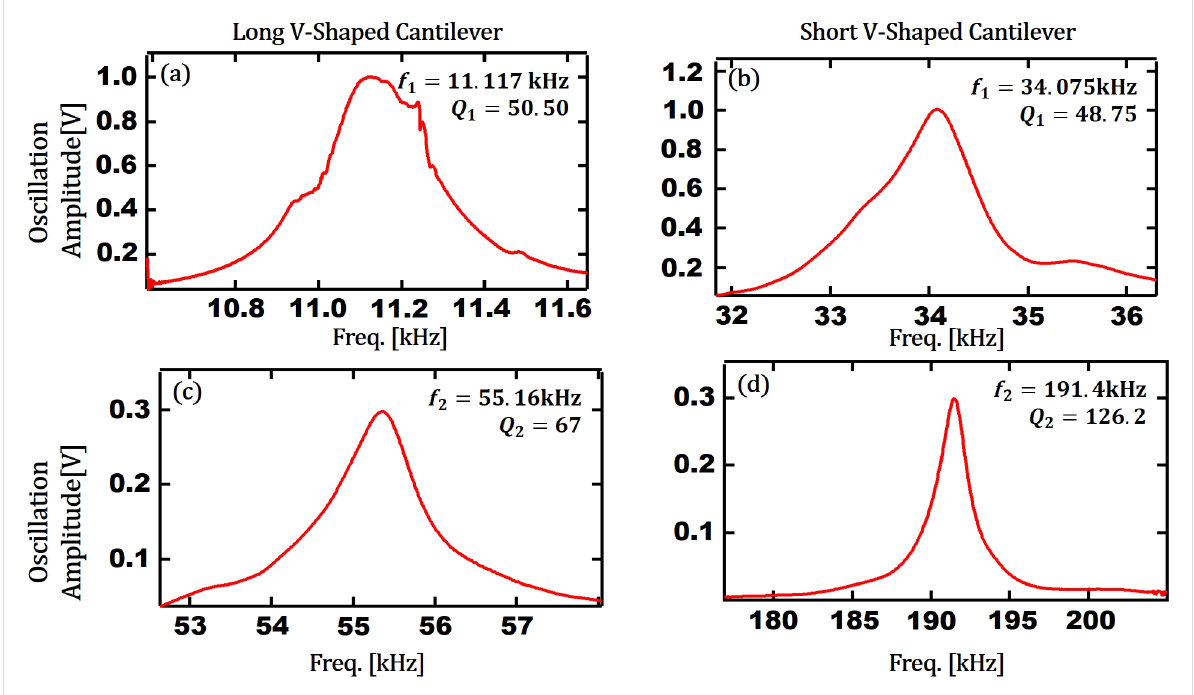
Figure 11: Amplitude versus frequency response: (a) 1st eigenmode frequency tune curve of the long V-shaped cantilever, (b) 1st eigenmode fre- quency tune curve of the short V-shaped cantilever, (c) 2nd eigenmode frequency tune curve of the long V-shaped cantilever and (d) 2nd eigenmode frequency tune curve of the short V-shaped cantilever.